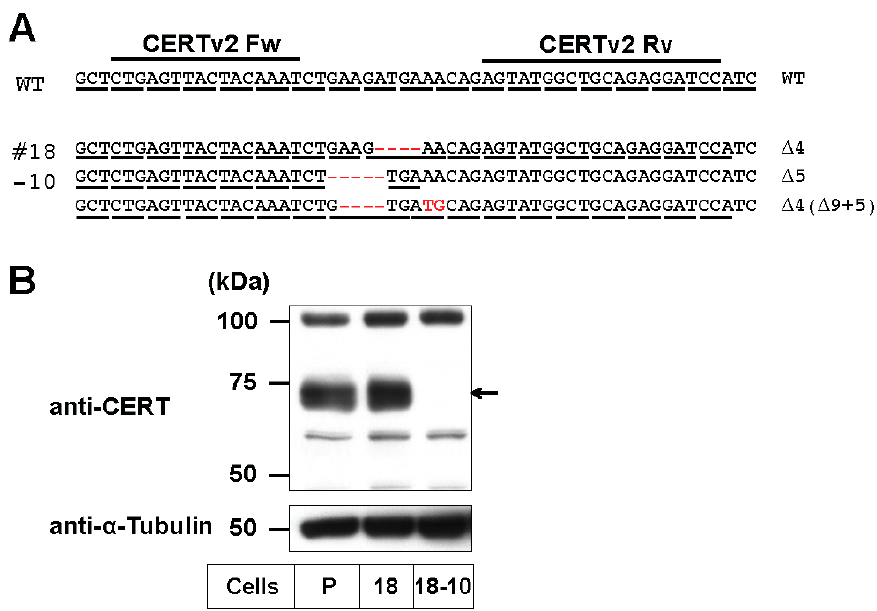
Figure 4. CERT gene disruption by the TALEN–CERT pair in the TAL-CERS2#18 clone. ( A ) The target site of the TALEN–CERT pair in the human CERT gene and indel analysis of the TAL-CERS2#18-CERT#10 (#18-10) clones. The target sequences (CERT Fw and Rv) are located in exon 2, which codes for part of the pleckstrin homology (PH) domain. Deletions and replacements are shown in red and their lengths are specified on the right of the sequences. WT, wild type; ( B ) Western blot analysis of CERT in the TAL-CERS2#18 clones. Cell lysates from the parent cells and the indicated mutants were immunoblotted with anti-CERT antibody ( top ) and anti- α -tubulin antibody ( bottom ). The arrow indicates CERT at 68 kD. P, parent cell line; 18, TAL-CERS2#18 clone; 18-10, TAL-CERS2#18-CERT#10 clone.